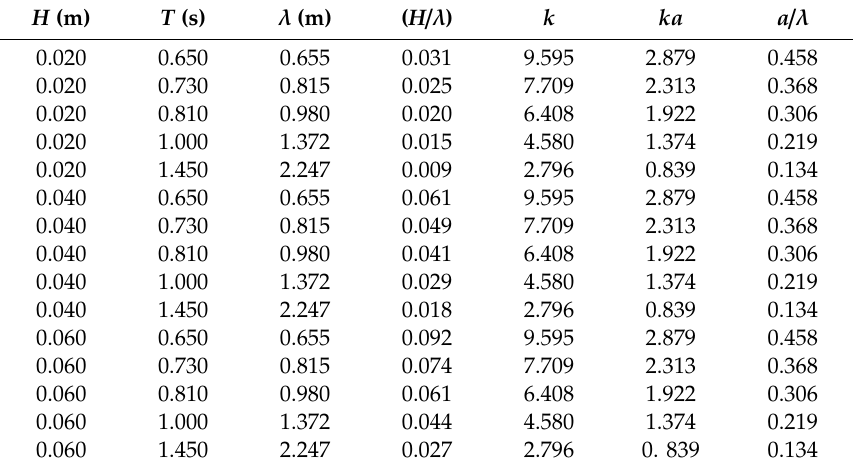
Table 3. Characteristics of generating waves (depth of water a = 0.3 m).